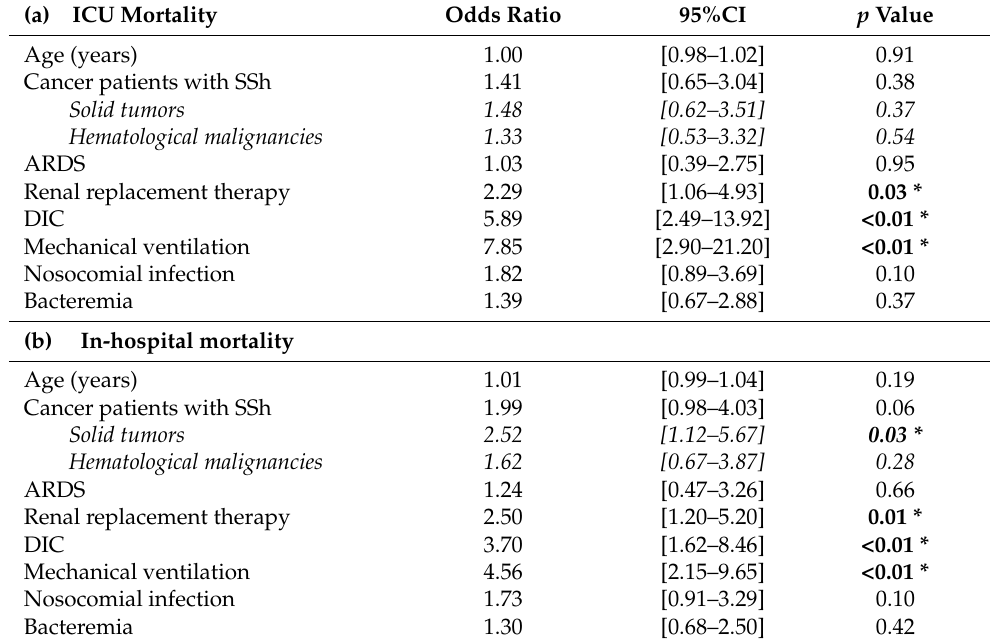
Table 3. Multivariate analysis of factors associated with ( a ) ICU mortality and ( b ) in-hospital